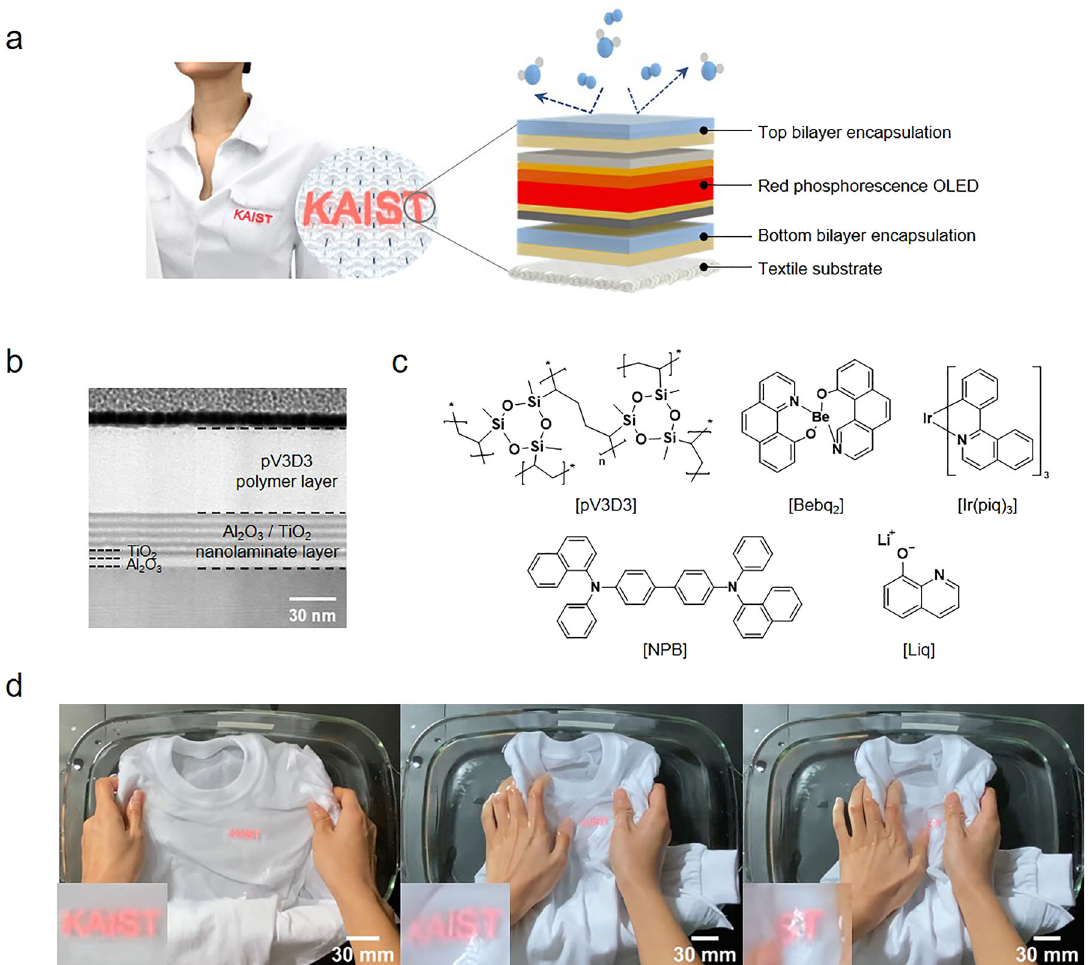
Fig. 1 Wearable OLED with a multi-functional encapsulation layer. a Illustration of the proposed textile-based OLED and encapsulation layer. b TEM image of the encapsulation layer. Scale bar, 30 nm. c Chemical structure of each layer, the polymer capping and host-dopant emitting layer (top), and the hole transport and electron injection layer (bottom). d Photographs of the wearable OLED being folded by hand in water. Scale bar, 30